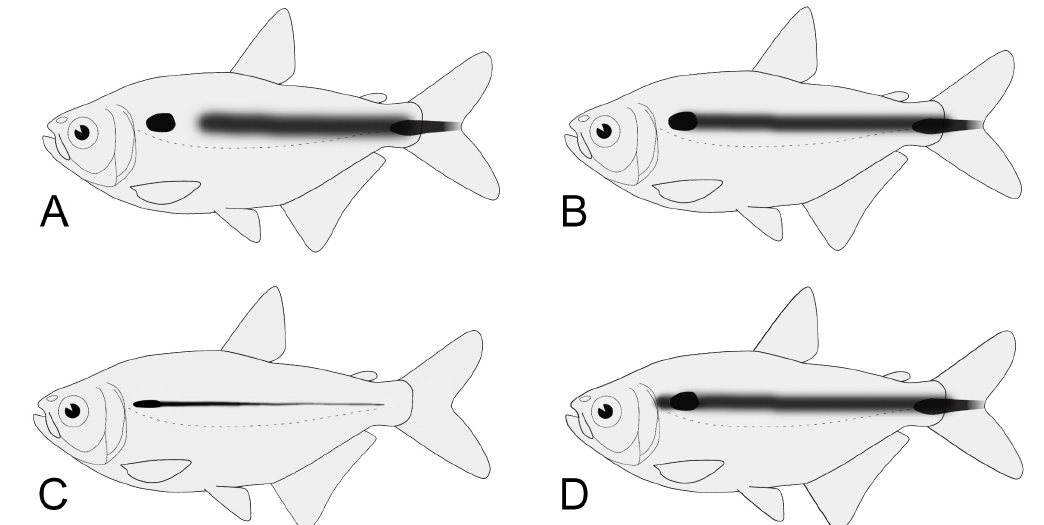
FIGURE 7 | Different types of dark midlateral stripes in Astyanax : A. Stripe of variously shapes and pigmentation starting posterior to the humeral blotch and never connected to it ( e.g. , A. bagual and A. eremus ); B. Stripe starting immediately posterior to the humeral blotch and usually ending at the tip of middle caudal-fin rays ( e.g. , species typically assigned to the Astyanax bimaculatus -group); C. Narrower stripe starting at posterior margin of the opercle, becoming blurred posteriorly and not reaching the caudal fin ( e.g. , Jupiaba anterior and J. ajuricaba ); D. Stripe starting immediately posterior to the opercle ( e.g. , A. joaovitori and A. scintillans ). See discussion for further details. Fish layout modified from Van der Sleen, Albert